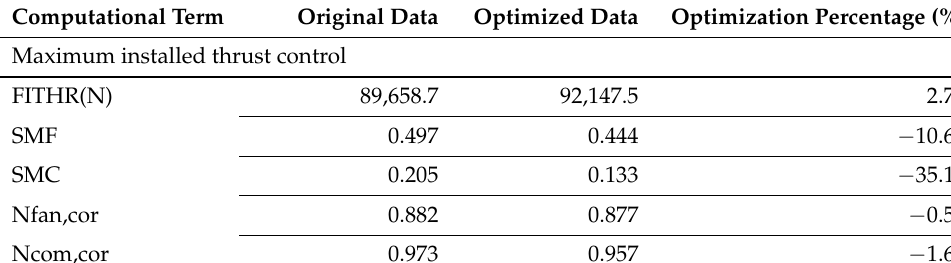
Table 2. Comparison of main parameters of PSC under Alt = 12.47 km Ma =